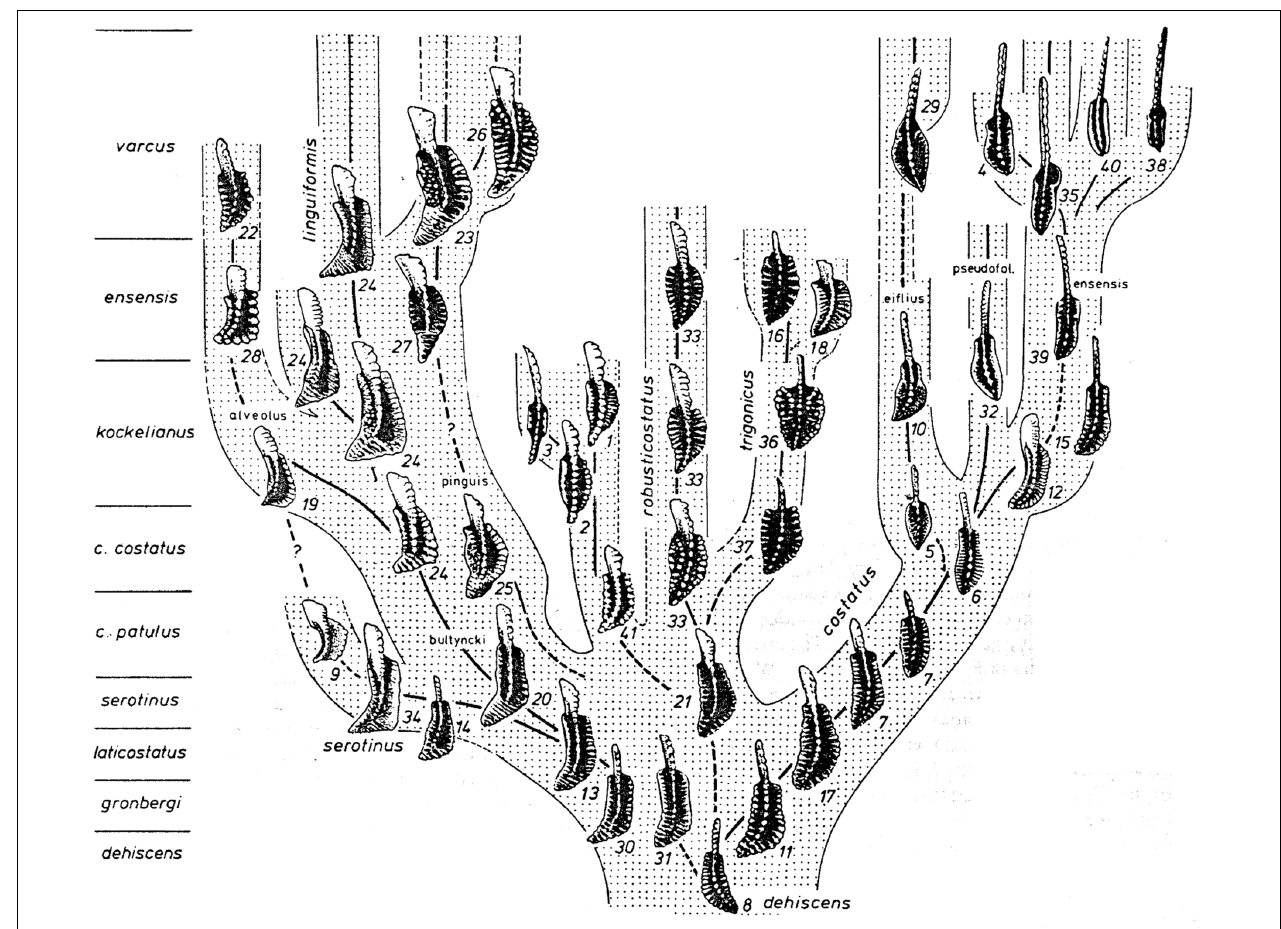
FIGURE 7 | An example of the supposedly gradual and dominantly anagenetic evolution of conodonts depicted in chronomorphoclines, in this case of the Devonian genus Polygnathus (after Weddige and Ziegler, 1979; used with the permission of the copyright holder, Michael Amler, University of Cologne,